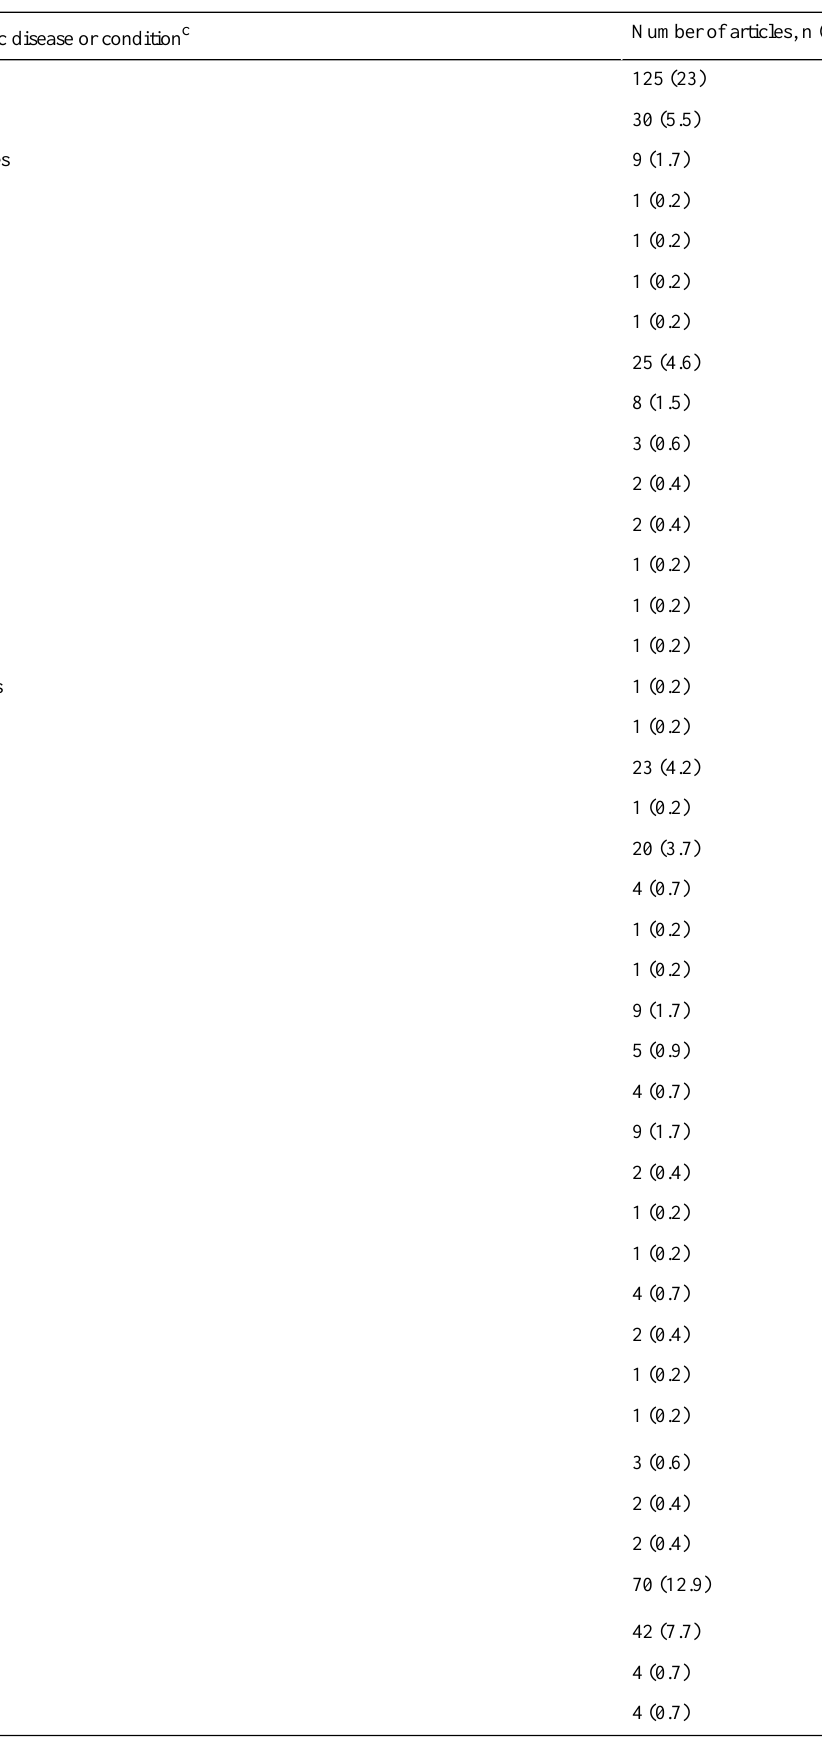
Table 4. Number of articles included in the review categorized according to various medical specialties, subspecialties, and specific disease conditions